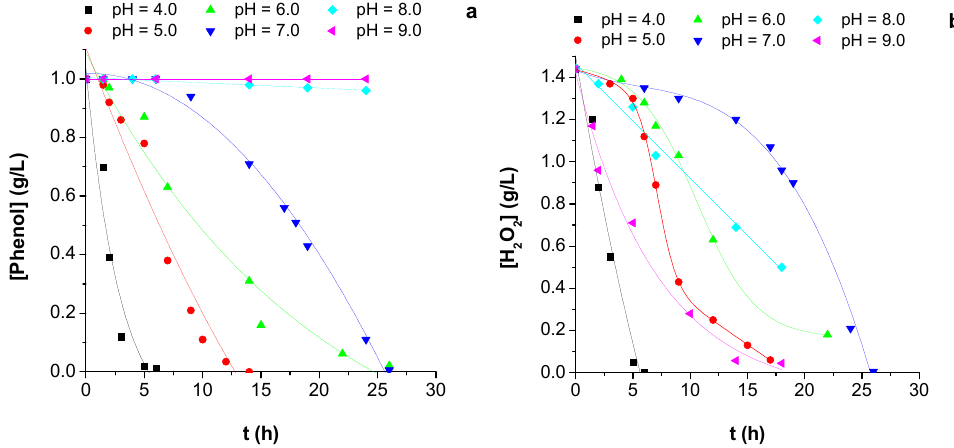
Figure 10. E ff ect of pH in phenol ( a ) and hydrogen peroxide ( b ) concentration during CWPO reaction Figure 10. Effect of pH in phenol (a) and hydrogen peroxide (b) concentration during CWPO reaction with gold supported on diamond as catalyst at di ff erent pH values. Lines were added merely to better with gold supported on diamond as catalyst at different pH values. Lines were added merely to illustrate the data trends ([phenol] initial = 1.0 g / L, [H 2 O 2 ] initial = 1.44 g / L, [catalyst] = 320 mg / L and better illustrate the data trends ([phenol] initial = 1.0 g/L, [H 2 O 2 ] initial = 1.44 g/L, [catalyst] = 320 mg/L and T = 50 ◦ C). Adapted from Mart í n et al. T = 50 °C). Adapted from Martín et al. [73].